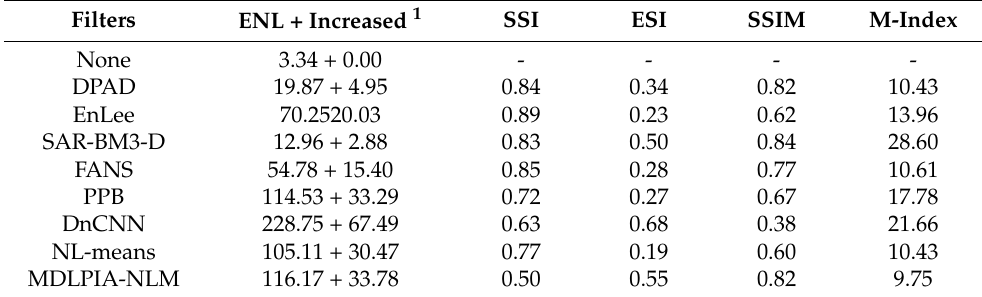
Table 4. Index evaluation for the TerraSAR-X SAR image.